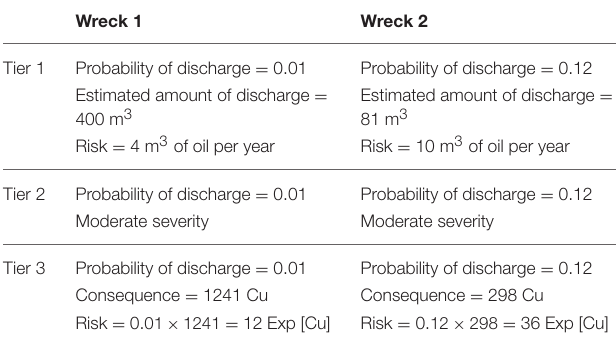
TABLE 5 | Results of consequence assessments on three tiers for two hypothetical